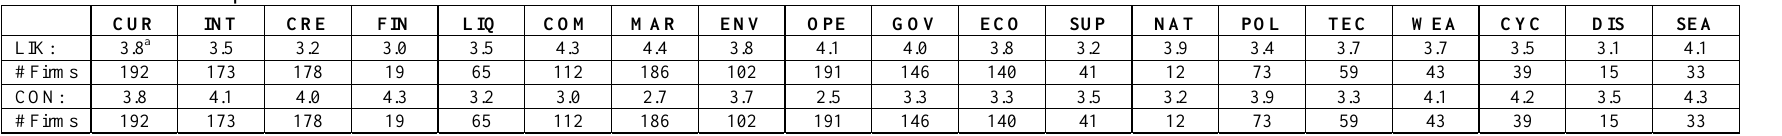
Table 2: Risk Assessment and Analysis Panel A: Total sample